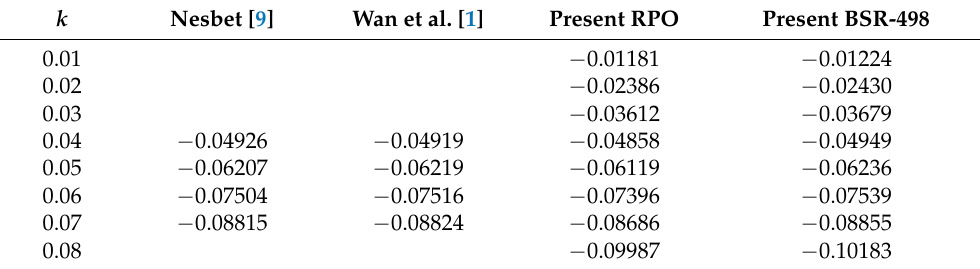
Table 4. S-wave phaseshift used to extract the scattering length for infinite nuclear mass.